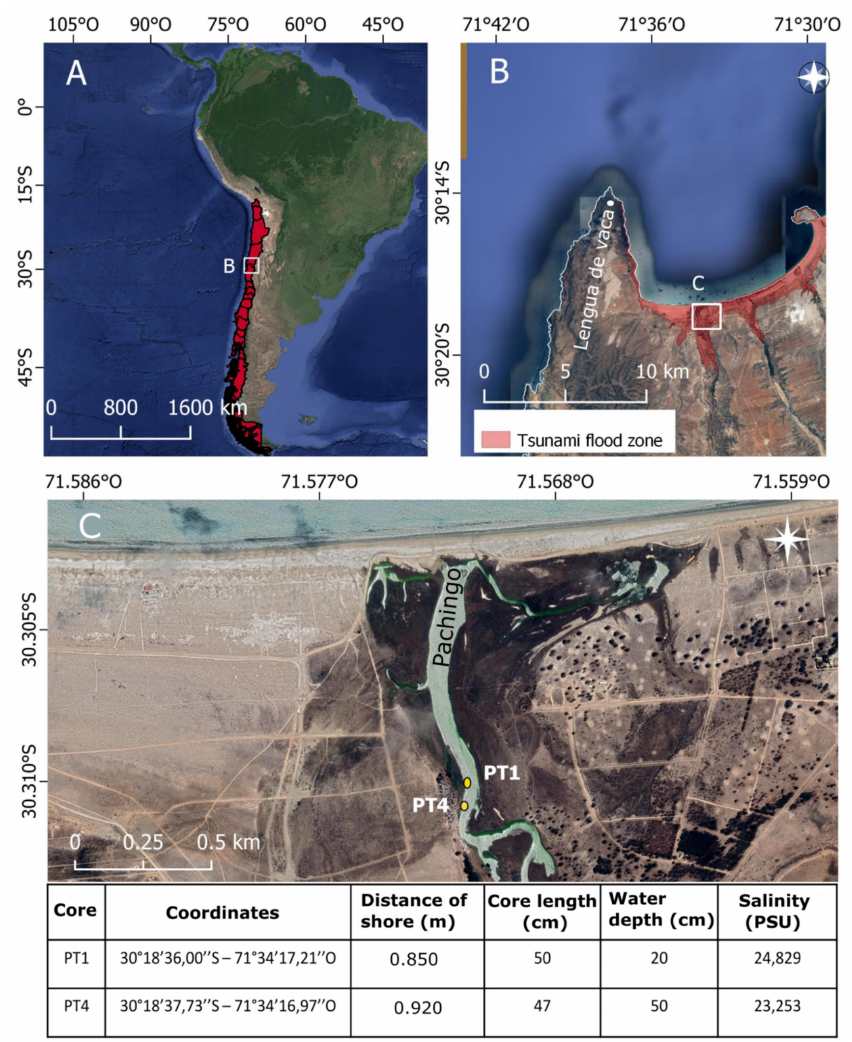
Figure 1. ( A ) Location of the study area, ( B ) Pachingo Wetland and in red tsunami flood zone according to Contreras-L ó pez et al. (2016), ( C ) location of sediment core sampling sites (PT1 and PT4). Source: QGis3.16 (google satellite). Details of sampling sites and cores are shown in the table